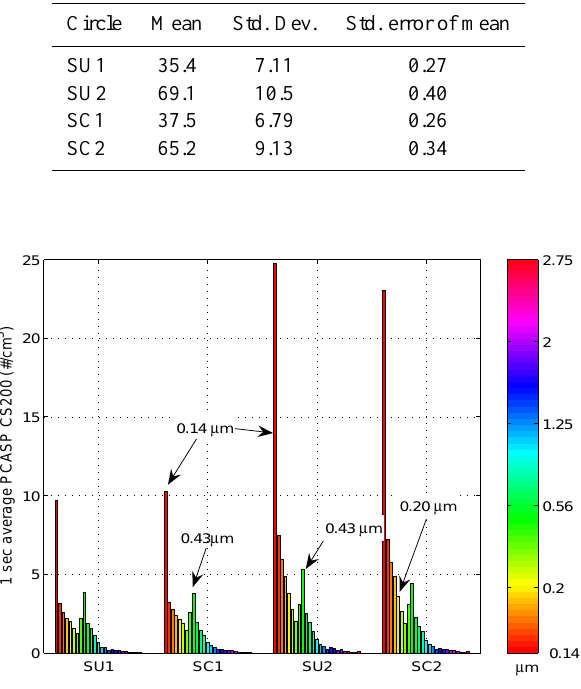
Fig. 3. Size spectra from 10Hz PCASP-200 integrated over the 500 s to 1200 s portions of the CBL circles of RICO RF14 excluding the periods of precipitation and pollution.